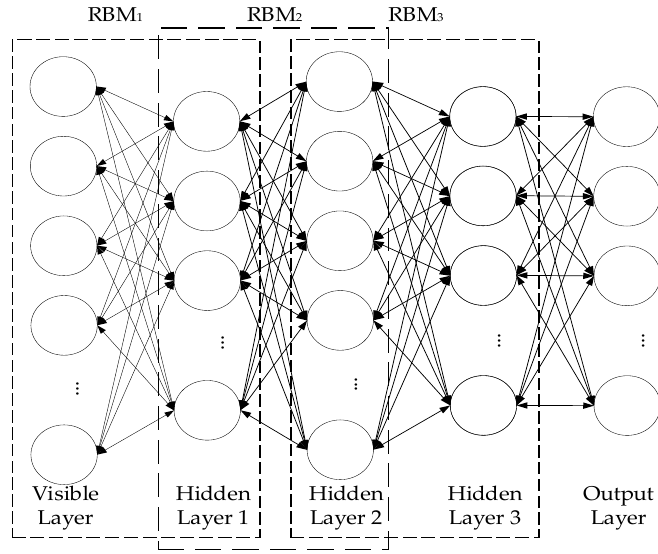
Figure 2. Deep belief network (DBN) constructed by RBMs.